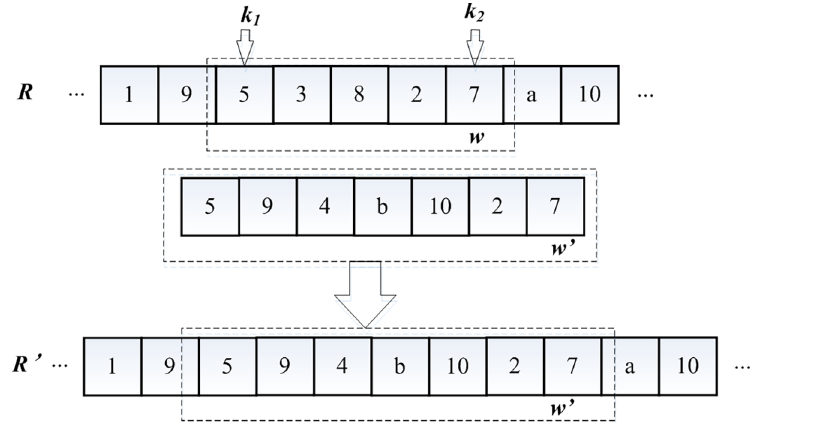
Fig 5. Variation diagram of chromosome segment